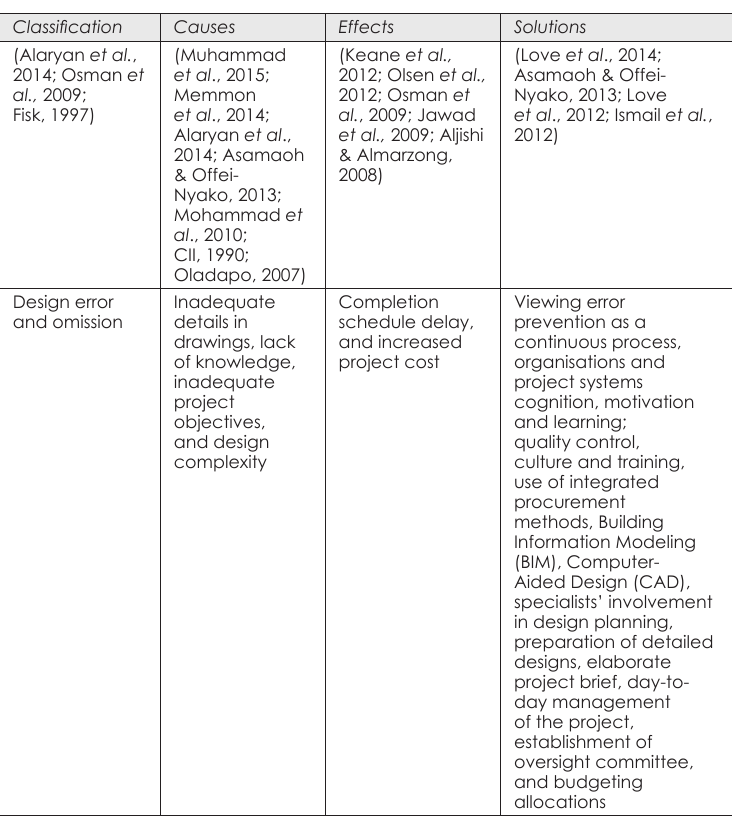
Classification of design-error-induced variations based on their causes, effects and